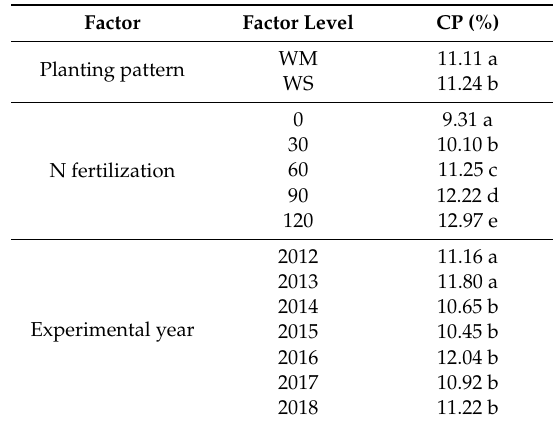
Table 3. Crude protein as a ff ected by planting pattern, nitrogen fertilization and the experimental year. Statistical di ff erences among crude protein within Planting pattern, N-fertilization doses and experimental